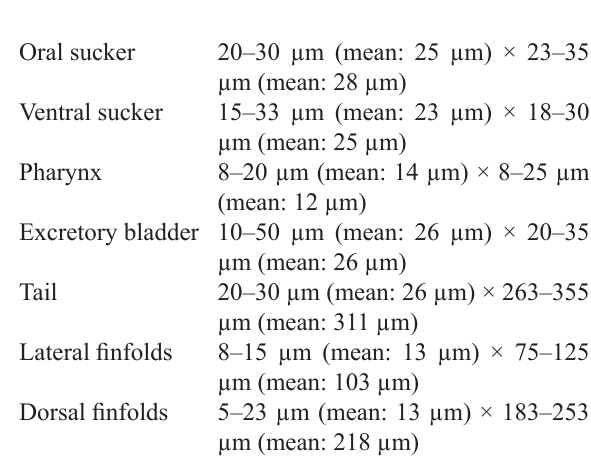
The body is oval in shape. The oral sucker is located at the anterior end of the body. There are three transverse